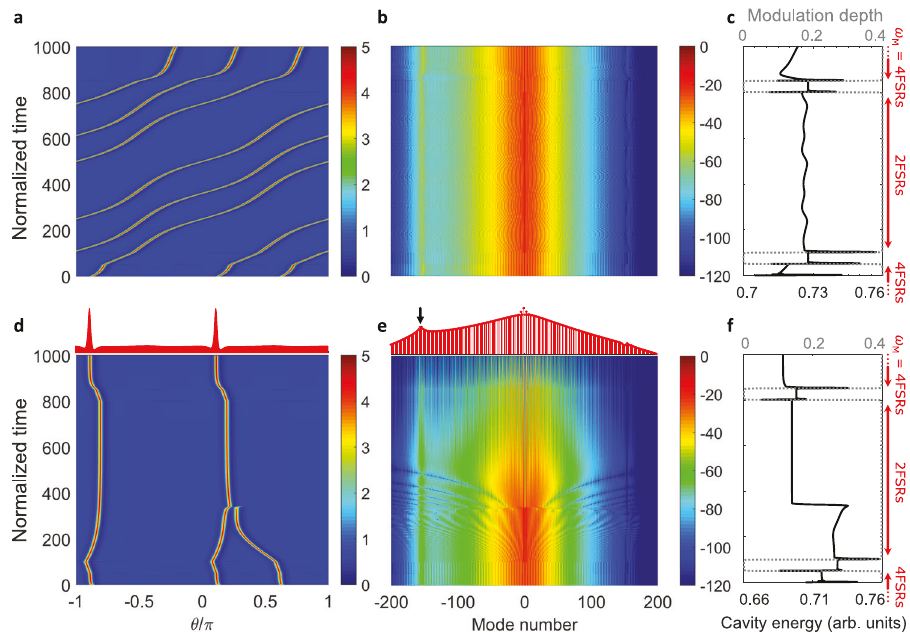
Fig. 8 Controlled discrete time crystal state switching in the presence of higher-order or perturbative effects. Compensation of soliton recoil by adjusting the modulation frequency. All numerical parameters are the same as those in Fig. 6, except for the non-zero third-order dispersion coef fi cient d = − 1.6 × 10 − 4 . Dispersive wave emission shifts the soliton spectral center (soliton recoil), changing the pulse repetition rate and resulting in the drift of 3 the pulse train in the rotating reference frame. a – c At ω M = MD 1 , the potential lattice is no longer stationary with respect to the soliton train, so that the same modulation depth (as when d 3 = 0) cannot create state switching. The relative motion of the modulation-induced lattice and pulse train modulates the soliton interaction energy, as seen in c . d – f By adjusting the modulation frequency to compensate for the soliton recoil (here η r = 2), it is possible to offset the effect of higher-order dispersion completely and effectuate discrete time crystal (DTC) state switching as before (cf. Fig. 6a – c). The fi nal soliton train and its spectrum are plotted on top of panels ( d ) and ( e ), respectively, with the black arrow pointing at the dispersive wave. a , d Temporal evolution of the pulse trains; b , e Frequency comb spectra; c , f Intra-cavity energy (bottom axes) and modulation depth (top axes). In c , f , FSR stands for free spectral